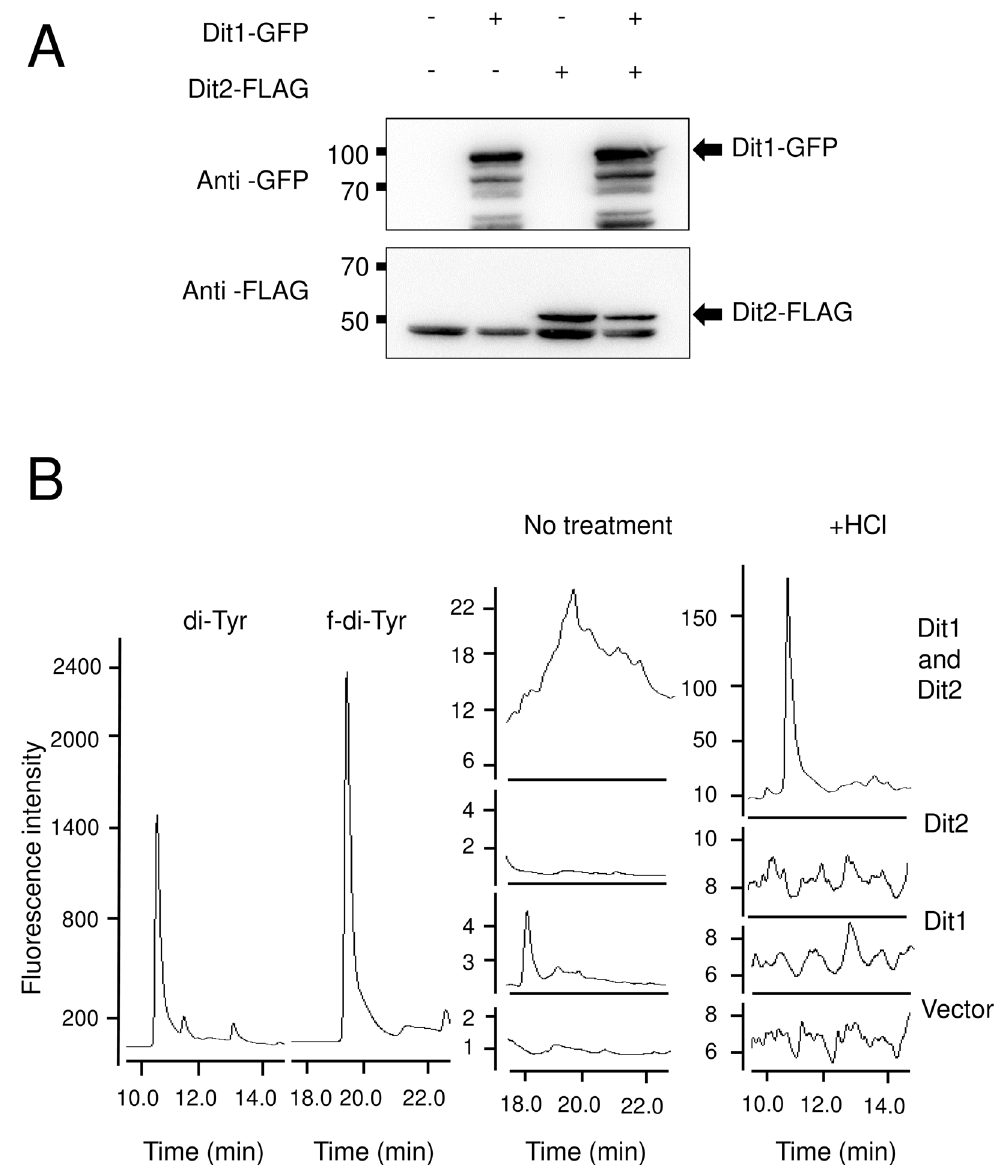
Figure 4. Dit1-GFP is active in vegetative cells. ( A ) Lysates from wild-type vegetative cells harboring pRS424GAL1-DIT1-GFP (Dit1-GFP) and / or pRS426GAL1-DIT2-FlAG (Dit2-FLAG) were subjected to Western blotting analysis using anti-GFP antibodies and anti-FLAG antibodies. ( B ) Lysates of vegetative cells harboring pRS424GAL1-DIT1-GFP (Dit1) and / or pRS426GAL1-DIT2-FlAG (Dit2) were treated with or without (no treatment) 6 N HCl and subjected to HPLC analysis. Dityrosine (di-Tyr) and formyl dityrosine (f-di-Tyr) are shown as controls.